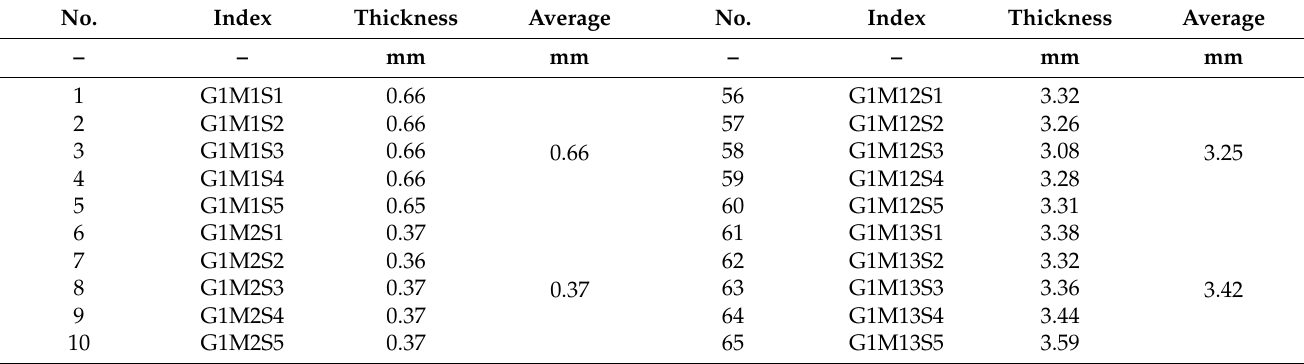
Table 4. Results of thickness measurements of substrates in the main